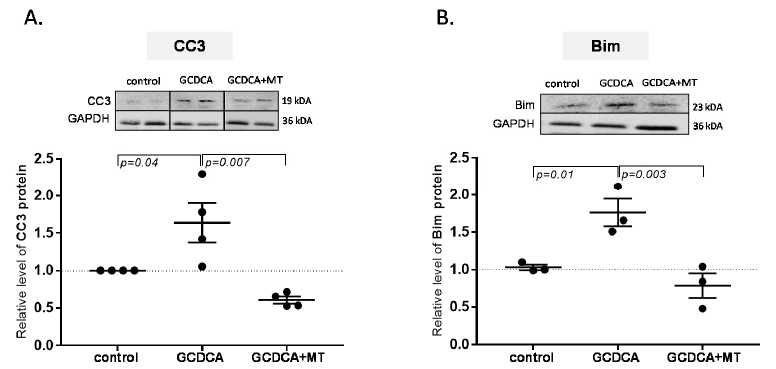
Figure 5. Melatonin protected against toxic bile acid-induced apoptosis in normal human cholangiocytes (NHCs). Melatonin suppressed the expression of sodium glycochenodeoxycholate (GCDCA)-induced ( A ) active form of caspase-3, cleaved caspase-3 (CC3), and ( B ) proapoptotic protein Bim. Protein levels were evaluated using Western blot and quantified relative to glyceraldehyde-3-phosphate dehydrogenase. Values are shown as mean ± SE.